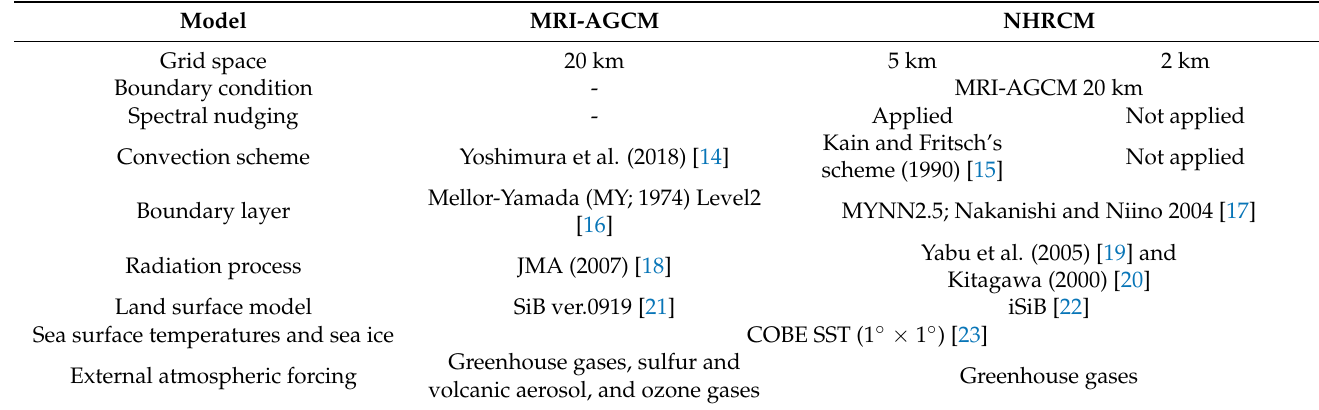
Table 1. Model specifications chosen in this study. Minimal details are given in main text, and full details are described in